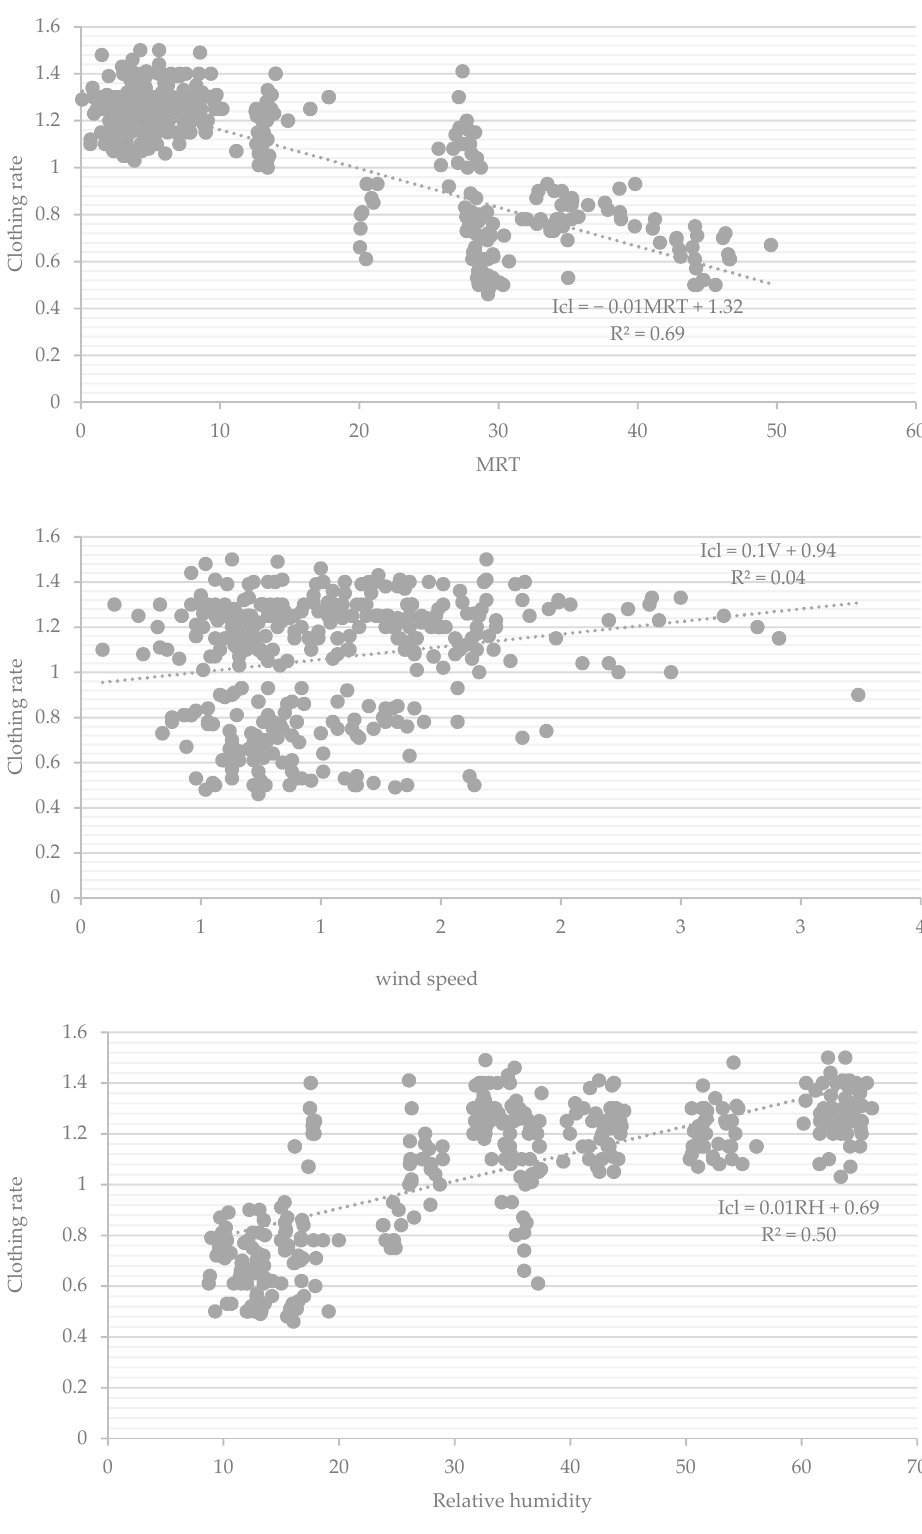
Figure 12. Influence of each independent environmental variable (TA, WS, MRT, and RH) on the mean value of clothing’s thermal insulation. This figure suggests that the increase in the air or mean radiant temperature decreased the clothing rate, while wind velocity and relative humidity had an opposite effect.